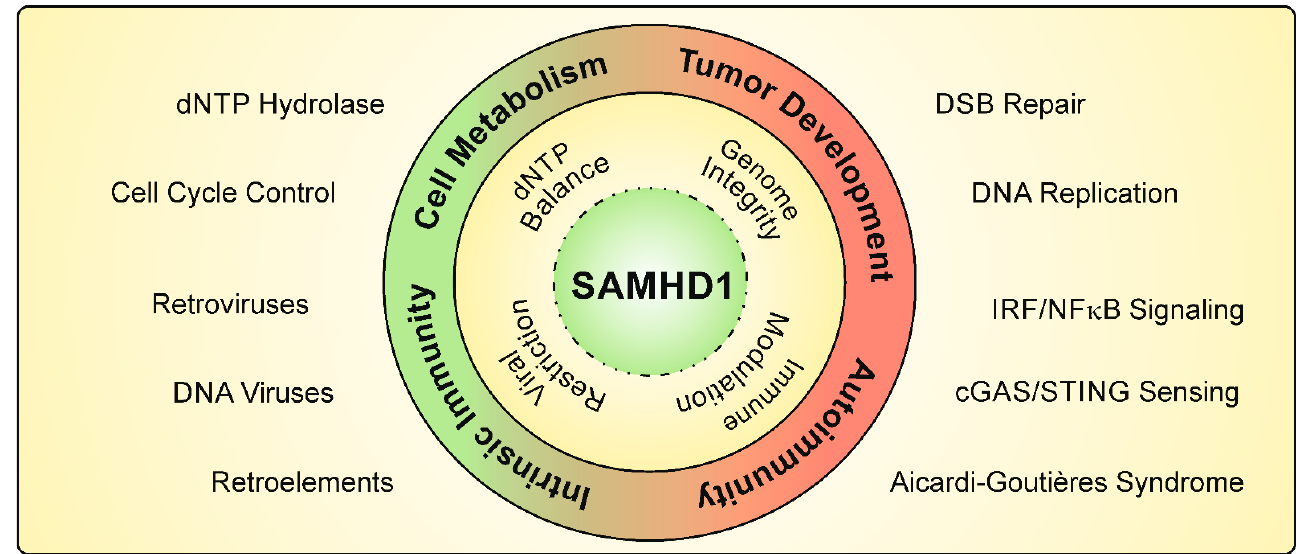
Figure 1. Cellular functions of SAMHD1. The dNTP triphosphohydrolase SAMHD1 is an important regulator of dNTP levels. A correct balance of the cellular dNTP pool has been shown to be important for cell-cycle control and genome integrity. SAMHD1 is a mediator of double-strand break (DSB) repair and ensures the progression of DNA replication. Mutations in the SAMHD1 gene have been identified in various types of cancer. Furthermore, SAMHD1 potently restricts viral infectivity of retroviruses and DNA viruses, and blocks the activity of endogenous retroelements. Mutations in SAMHD1 are correlated with autoimmune diseases such as Aicardi–Goutières syndrome, resulting in elevated type I IFN levels. SAMHD1 also impairs the innate immune sensing of viral infections by interfering with cGAS/STING nucleic acid recognition and NF κ B/IRF signaling pathways.